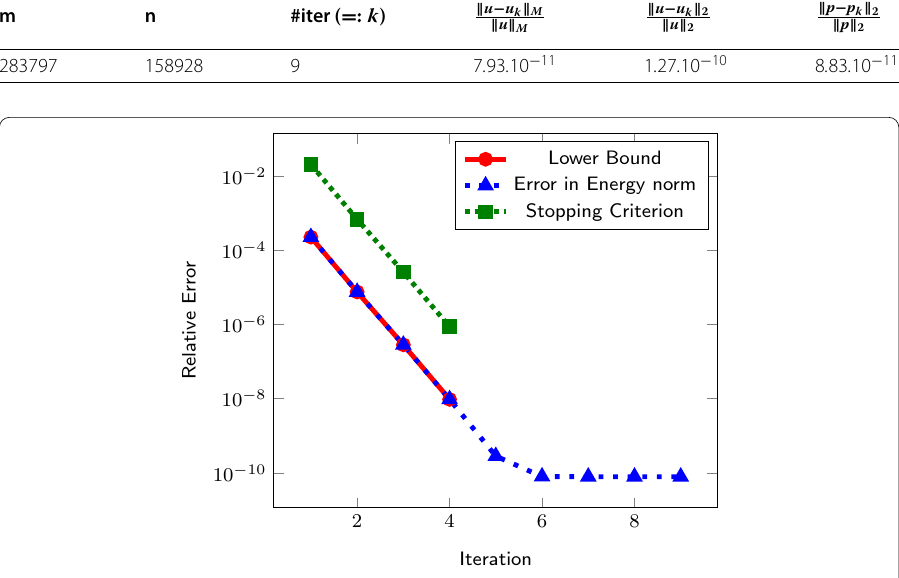
Table6 GKB convergence for the containment building example